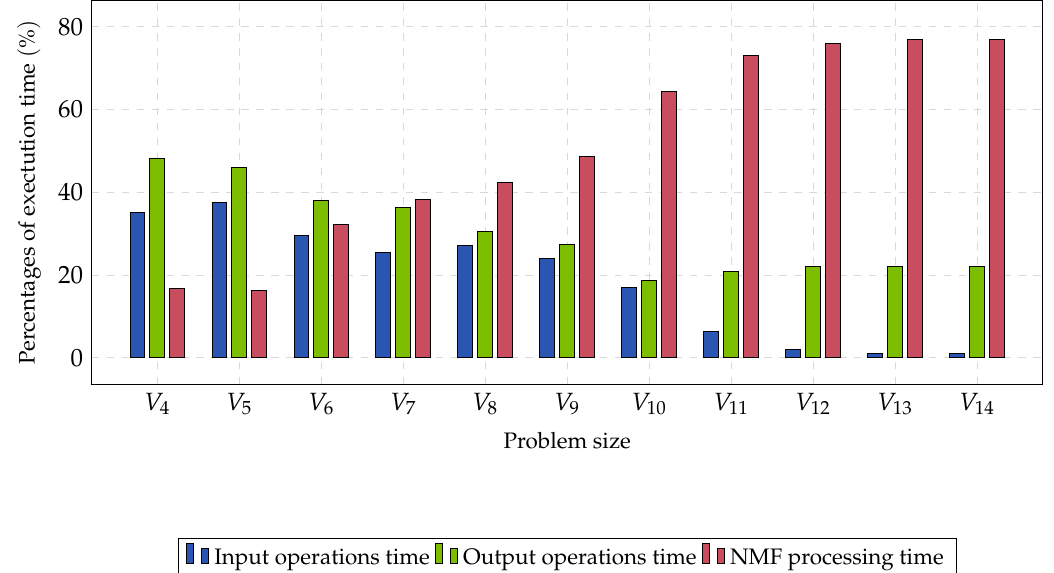
Figure 2. Percentages of the execution time of the three phases of the algorithm (reading, processing, and writing). Eleven matrices were tested ( V 4 ∈ R 10,200 , V 5 ∈ R 50,200 , V 6 ∈ R 100,200 , V 7 ∈ R 150,200 , V 8 ∈ R 200,200 , V 9 ∈ R 250,200 , V 10 ∈ R 300,250 , V 11 ∈ R 350,200 , V 12 ∈ R 400,200 , V 13 ∈ R 450,200 , V 14 ∈ R 500,200 ), (cid:101) = 10 − 12 , k ∈ [ 2,10 ] , and T = 1000: the maximum number of executions to obtain a statistically significant